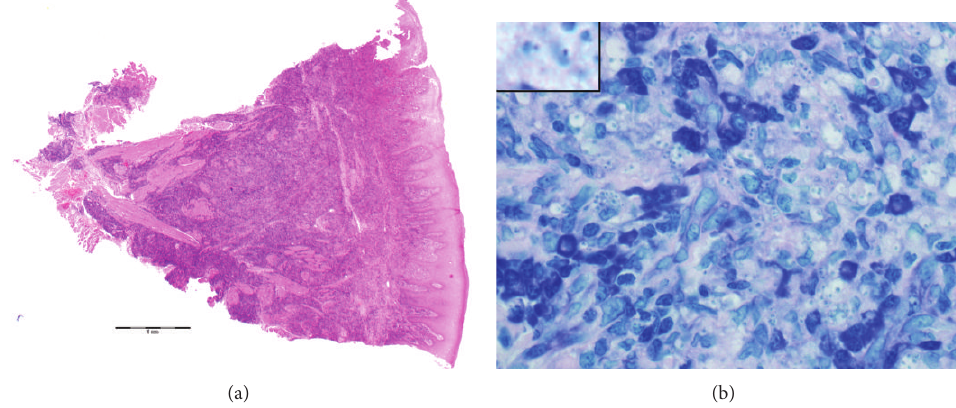
Figure 2: Histopathology. (a) shows a low-power ( × 20) view of a cross section of the initial tongue biopsy stained with H and E and demonstrates the intense histiocyte-rich inflammatory infiltrate, sparing the squamous epithelium (right) and almost filling the corium extending deep into the soft tissues. (b) shows an oil immersion high-power view of the histiocytic infiltrate ( × 1000) stained with Giemsa and shows the histiocytes with many intracellular amastigote forms characterized by the “double-dot” sign (inset × 4 compared to the original). These are the Leishman-Donovan bodies.